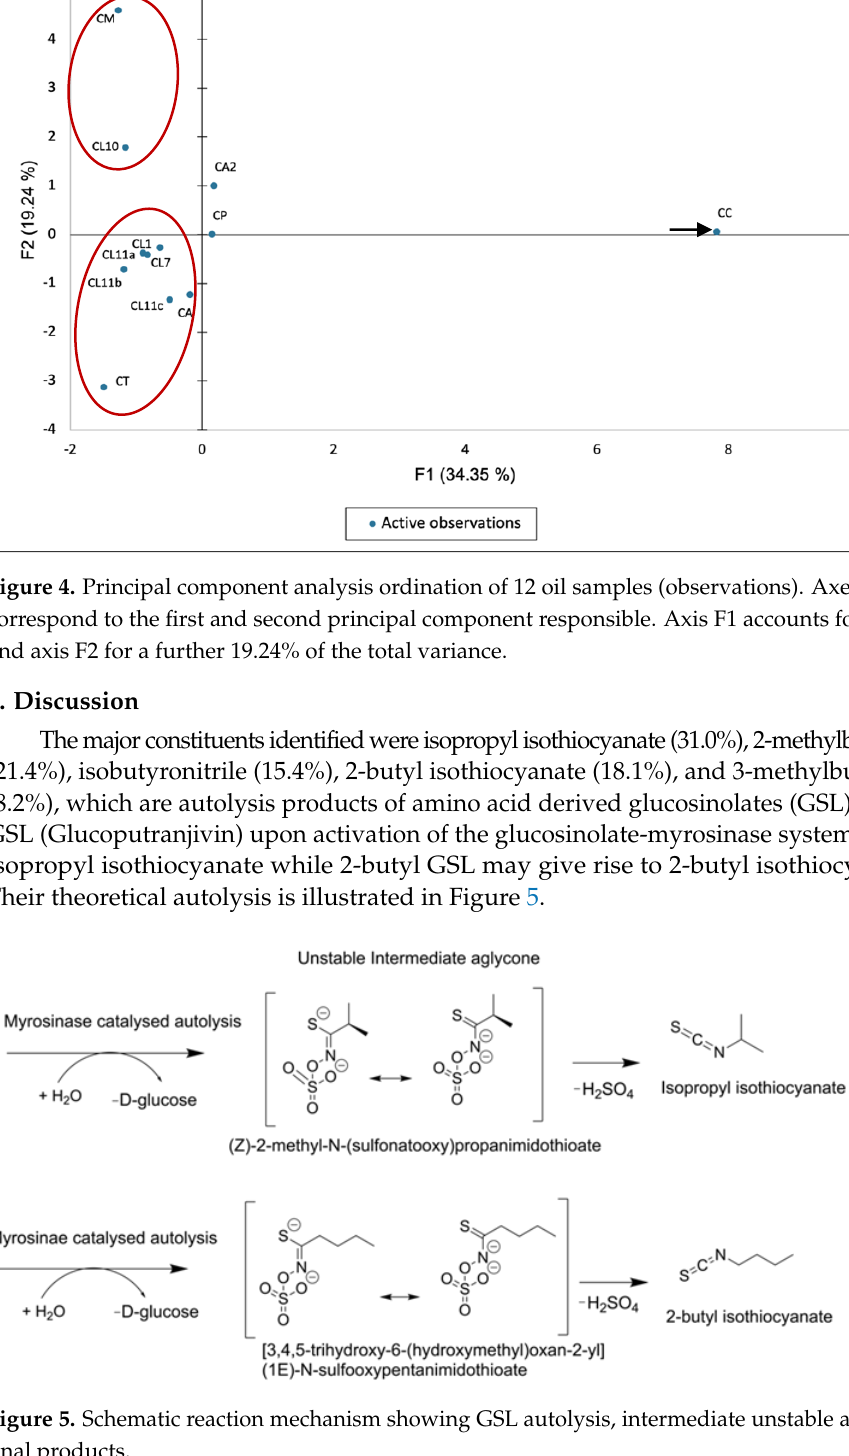
Figure 3. Dendrogram (AHC analysis) representing the chemical composition dissimilarity relation- ships of 12 essential oil samples (observations) obtained by Euclidian distance dissimilarity using the aggregation criterion of Ward’s method. Two main groups of samples (C1 and C2) were found.